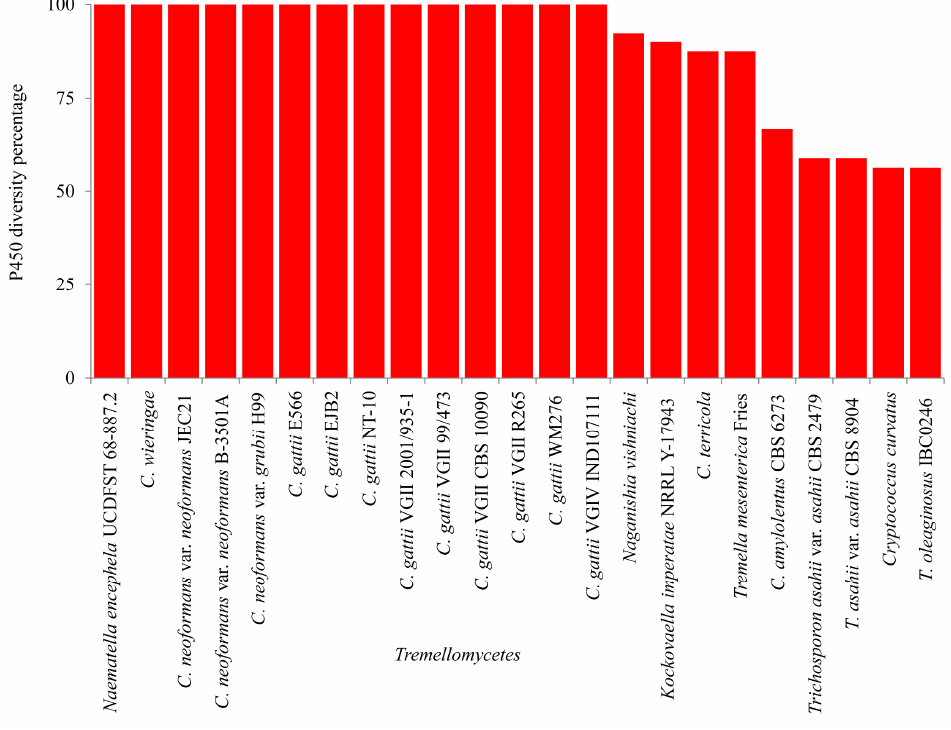
Figure 5. CYP diversity percentage analysis in Tremellomycetes .